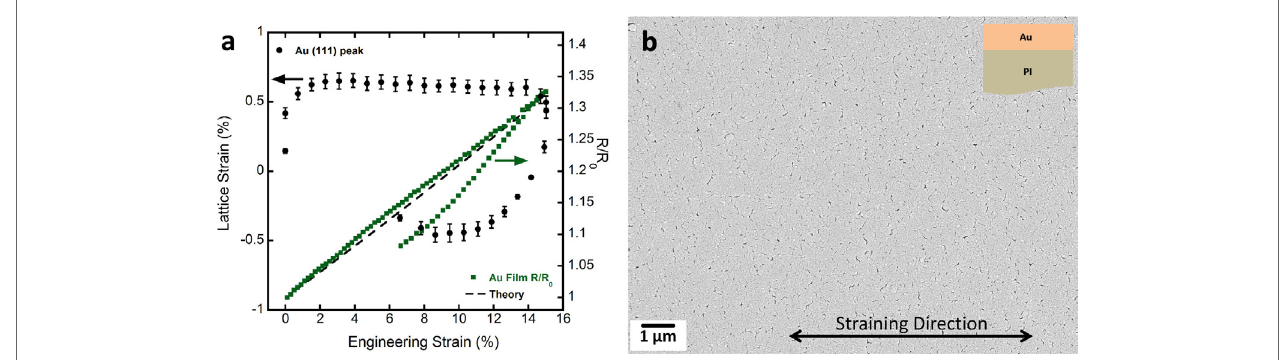
FigUre 3 | (a) In situ XRD and 4PP results of the 300-nm Au film on PI illustrating ductile film electro-mechanical behavior. Black circles are the lattice strains and green squares the electrical resistance. (B) SEM micrograph of the Au film surface after straining to 15% showing areas of localized thinning and possible through thickness cracks.